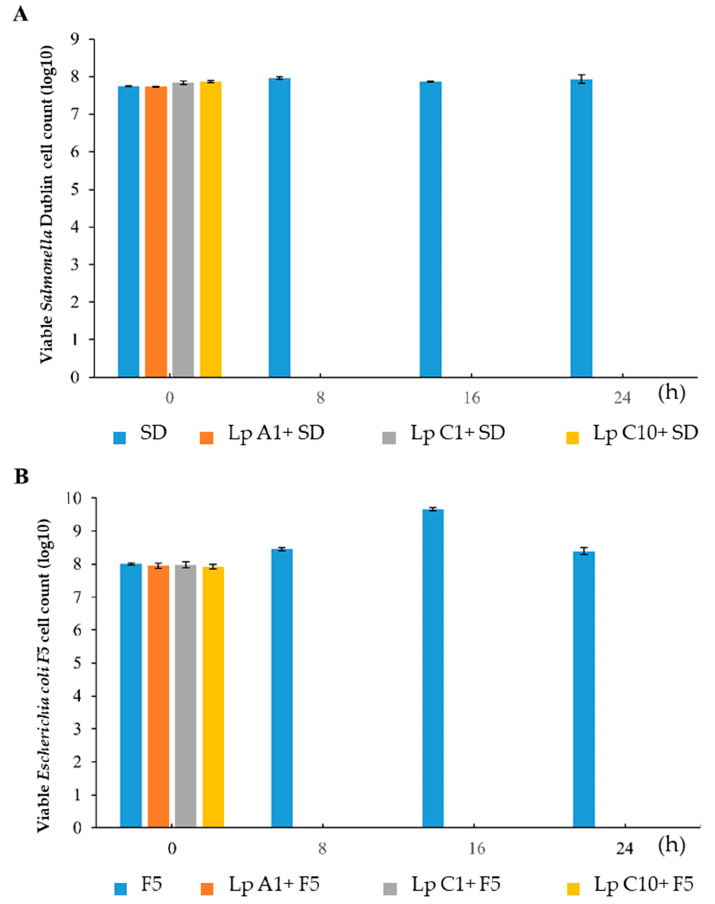
Figure 2. Monoculture or coculture of Salmonella Dublin ( A ) or Escherichia coli F5 ( B ) with Lactiplantibacillus plantarum A1, C1 and C10. SD = Salmonella Dublin; F5 = Escherichia coli F5; Lp = Lactiplantibacillus plantarum .